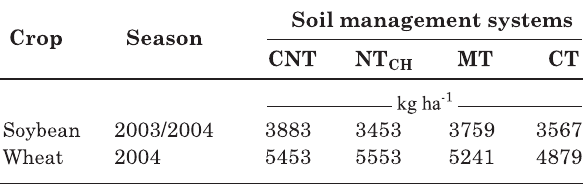
Table 2. Soybean (harvest 2003/2004) and wheat (harvest 2004) yield in the experimental area under continuous no-tillage (CNT), no tillage with chisel plow (NT ), minimum tillage (MT) CH and conventional tillage (CT)